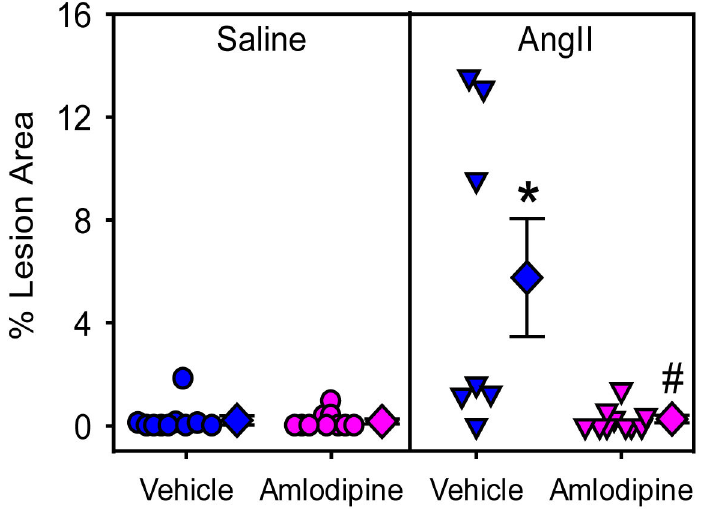
Figure 6. Amlodipine reduced AngII-induced atherosclerosis. Percent atherosclerotic lesion area of thoracic aortas were measured by an en face method. Circles and triangles are individual measurements, diamonds are means of the groups, and error bars are SEMs. Statistical analyses were performed using nonparametric Kruskal-Wallis test. * denotes P=0.02 for comparison between AngII + vehicle and saline + vehicle groups, and # denotes P=0.05 for comparison between AngII + amlodipine and AngII + vehicle